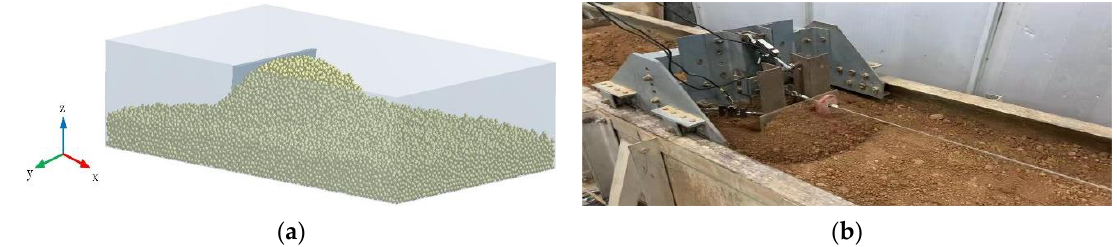
Figure 11. The diagram of soil cutting process. ( a ) Simulation test. ( b ) Actual test.